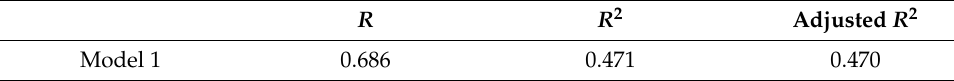
Table 16. Variance analysis of the regression model. Sum of Squares df Mean Square F p -Value Regression 71,030.01 2 35,515.00 627.60 0.000 Residual 79,902.63 1412 56.59 Total 150,932.64